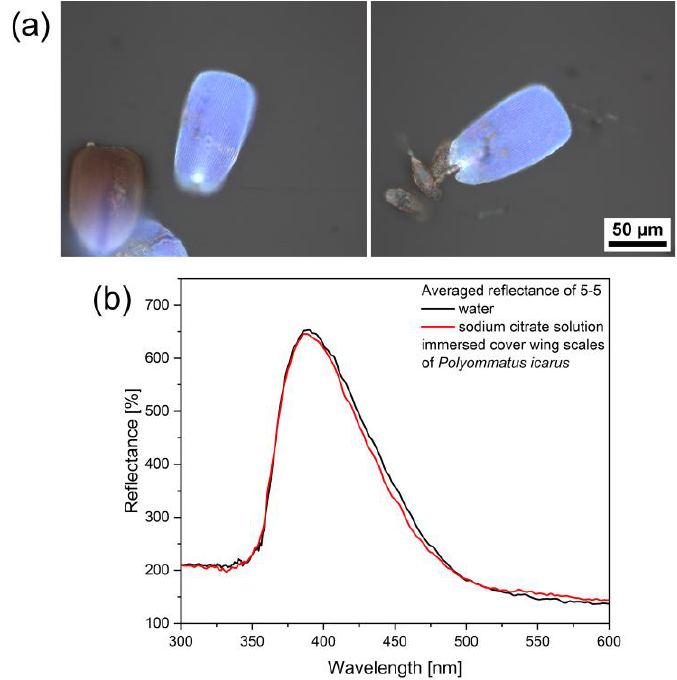
Figure 8. ( a ) Microphotographs of the single scales removed from the only water-soaked wing (left) and from the wing subjected to sodium citrate treatment (right); ( b ) comparison of the averaged reflectance curve for the two different kinds of scales. Note the sharp cutoff below 370 nm due to the glass optics of the microscope.